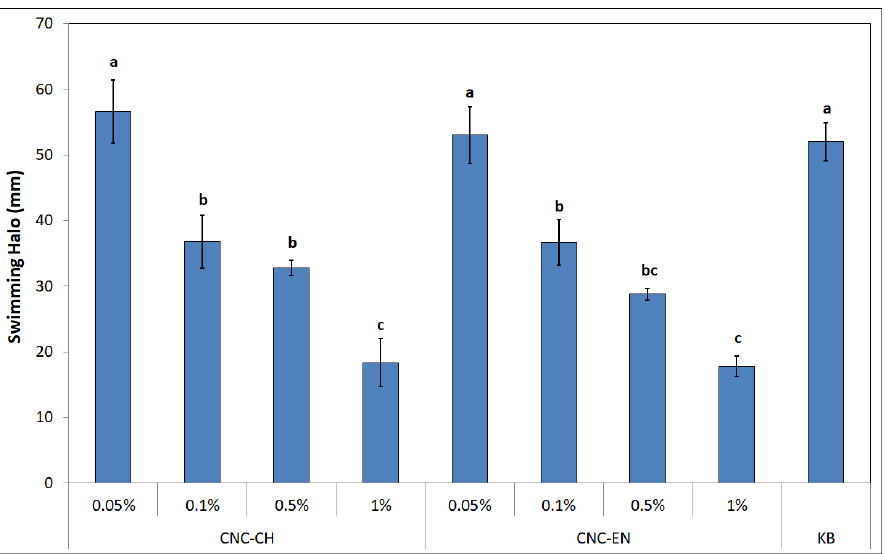
Figure 12. Swimming halos of Pto after 48 h of incubation at 27 °C on soft agar amended with different concentrations of CNC. Data represent the mean and standard deviation; different letters show significantly different values after one-way ANOVA, followed by Tukey’s HSD post hoc test ( p < 0.05 ).